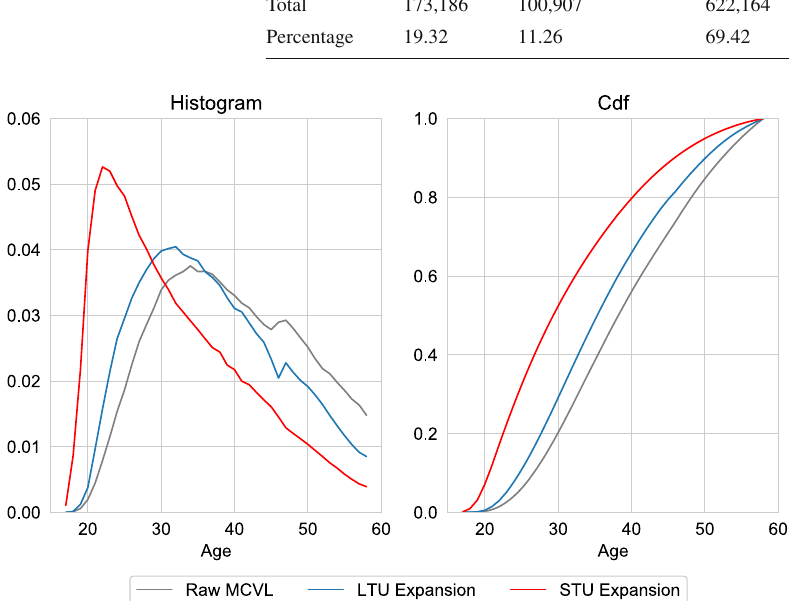
Fig. 5 Age distribution by expansion. All spells in the 2005–2013 period, by expansion. Source : MCVL